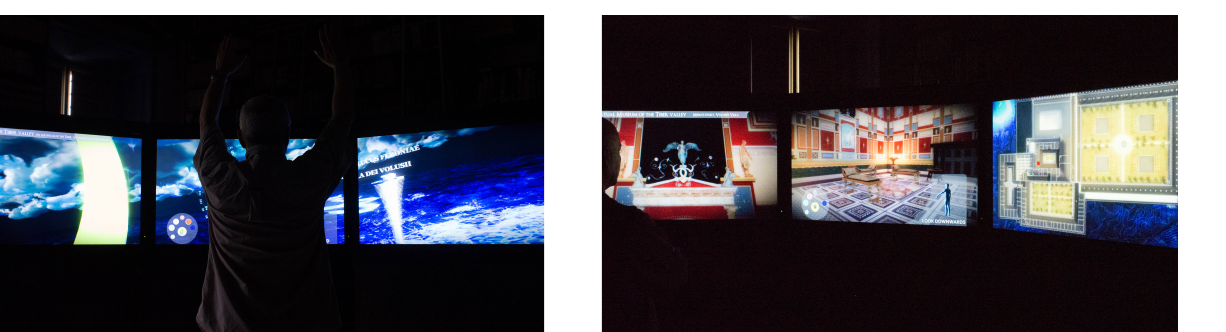
Figure 4. Virtual Museum of the Tiber Valley . Volusii’s Villa scenario